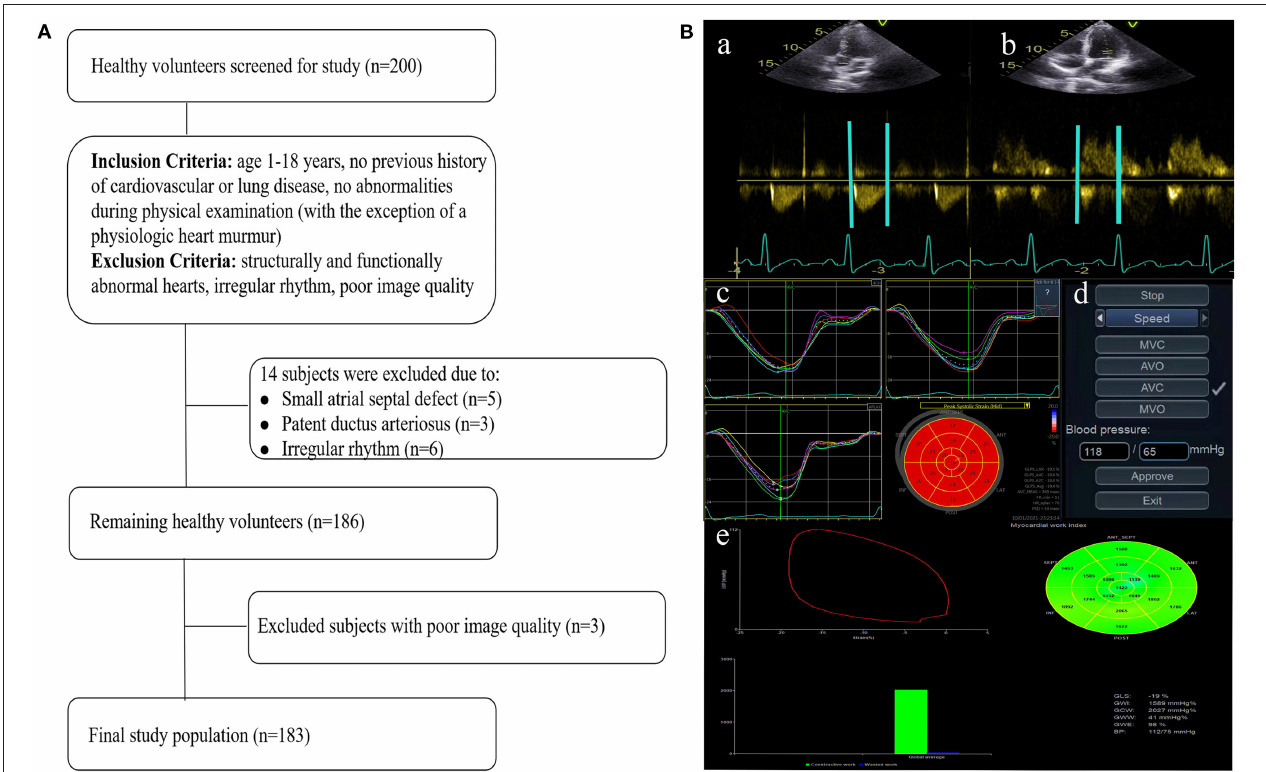
FIGURE 1 | Flow chart detailing the identification of the study cohort (A) and image analysis for myocardial work indices (B) . Eventing time was determined based on the Doppler flow spectrum of the aortic valve (a) and mitral valve (b). Tracking was automatically performed to determine segmental and global longitudinal strain (c). After entering the cuff blood pressure value (d), the software automatically generated the PSL curve and myocardial work indices (e). The lower right corner of figure e displays the myocardial work indices obtained from the PSL curve. PSL, pressure-strain